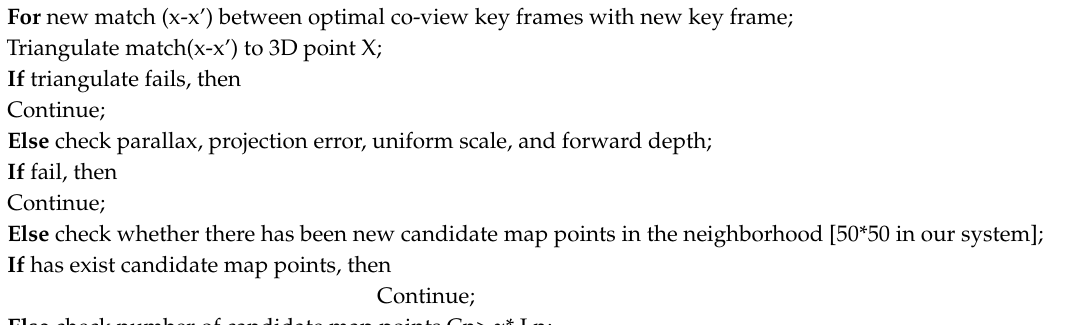
Algorithm 1. Candidate map points selection